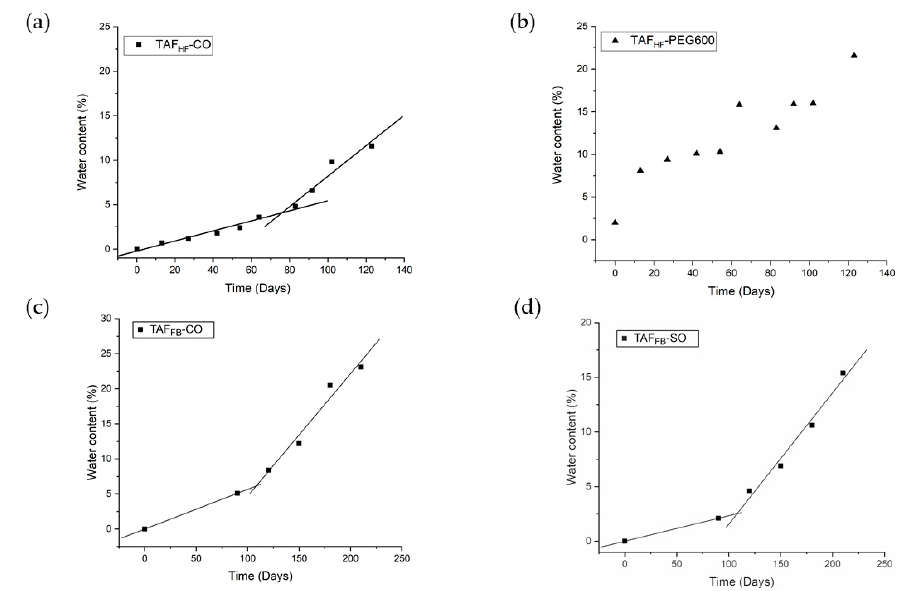
Figure 4. Water ingress profiles of TAF HF -CO ( a ), TAF HF -PEG600 ( b ), TAF FB -CO ( c ), and TAF FB -SO ( d ) formulations within PCL implants exposed to simulated physiological conditions (37 °C, PBS). Two-line model (depicted in black lines) has been applied to TAF HF -CO, TAF FB -CO and TAF FB -SO formulations in mass ratios of 2:1.